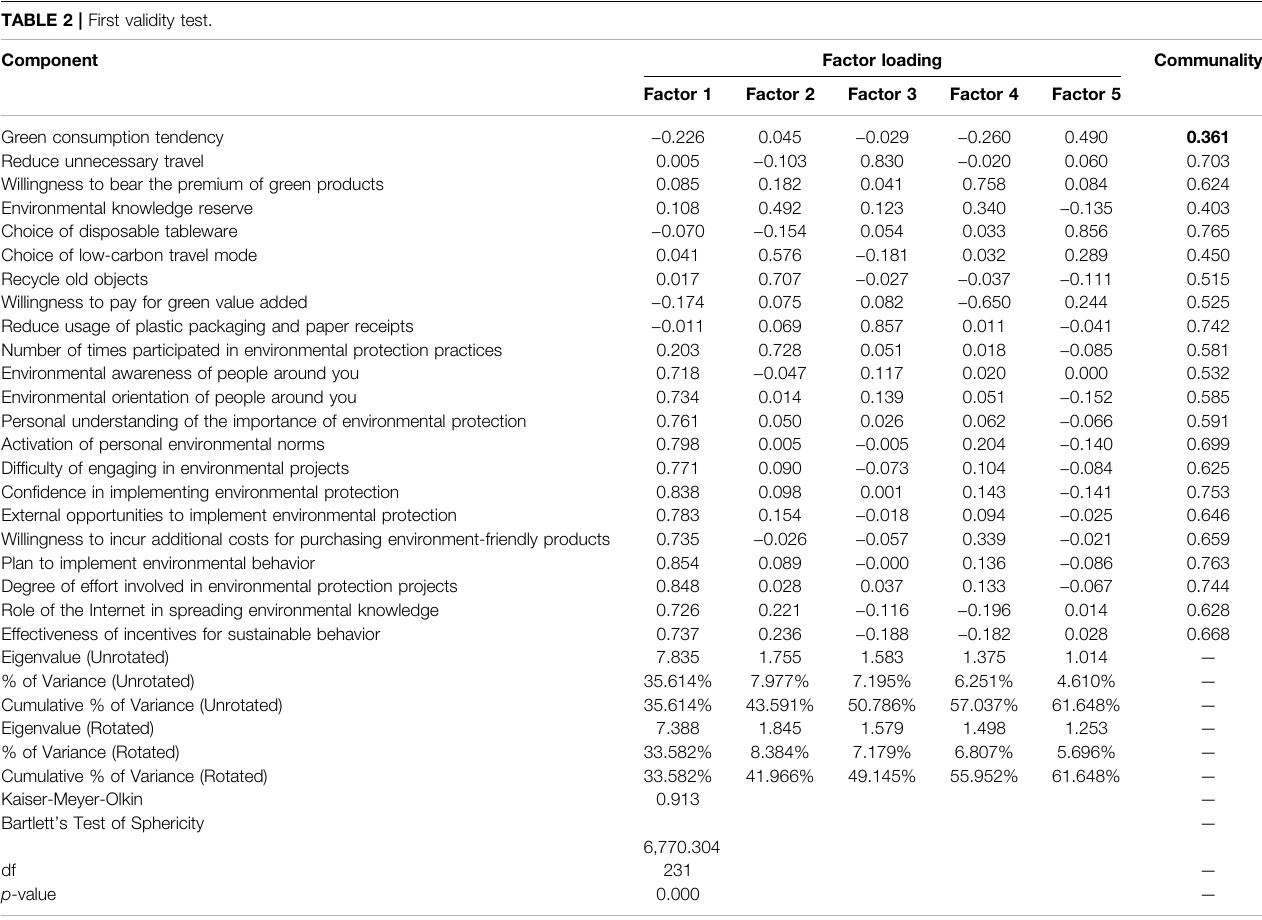
Bold indicates < 0.4 which means it didn ’ t pass the empirical